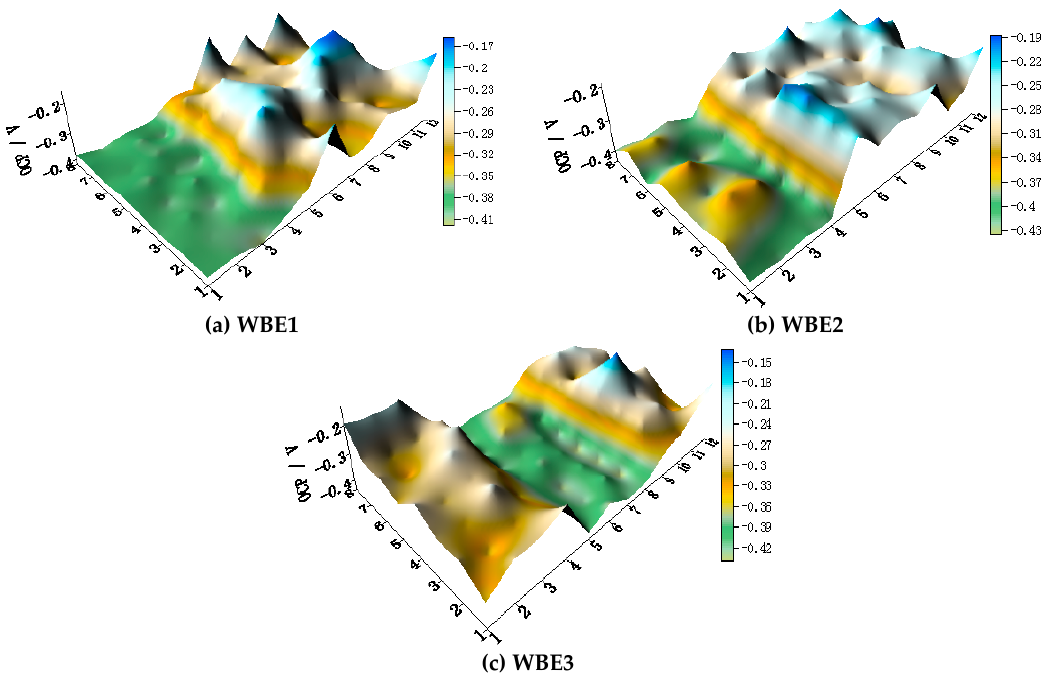
Figure 19. The OCP distribution maps of the three electrodes after immersion in artificial seawater with 2.7 wt % Cl − at 70 °C: ( a ) WBE1, HAl77-2/316L SS/TA2; ( b ) WBE2, HAl-77-2/TA2/316L SS; and ( c ) WBE3, TA2/HAl77-2/316L SS.